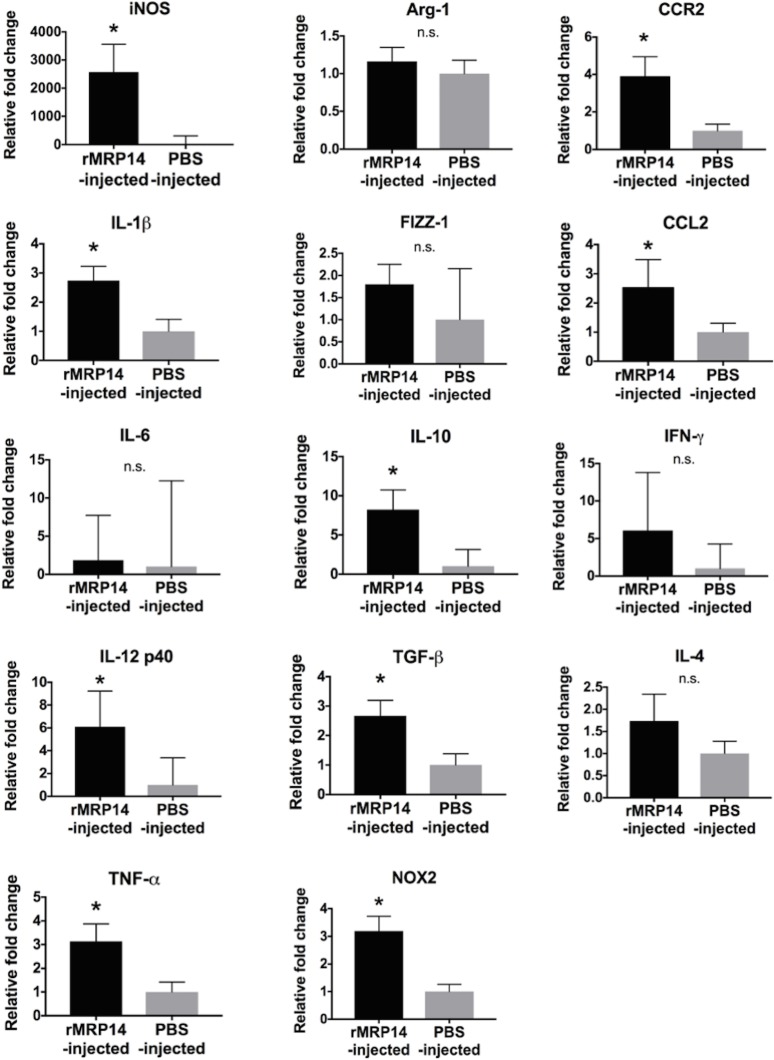
The expression of pro-inflammatory molecules promoted by rMRP14 injection.mRNA expression of iNOS, IL-1β, IL-6, IL-12 p40, TNF-α, Arg-1, FIZZ-1, IL-10, TGF-β, CCR2, CCL2, IFN-γ and IL-4 in the liver of mice injected with rMRP14 or PBS (n = 5). Graphs show mean and SD of each group. Data are representative of two independent experiments. *P < 0.05; n.s., not significant.